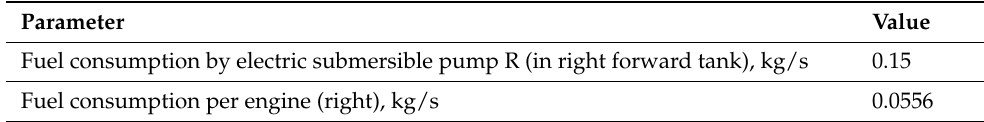
Figure 4. Example of dynamic calculation data under refueling mode.